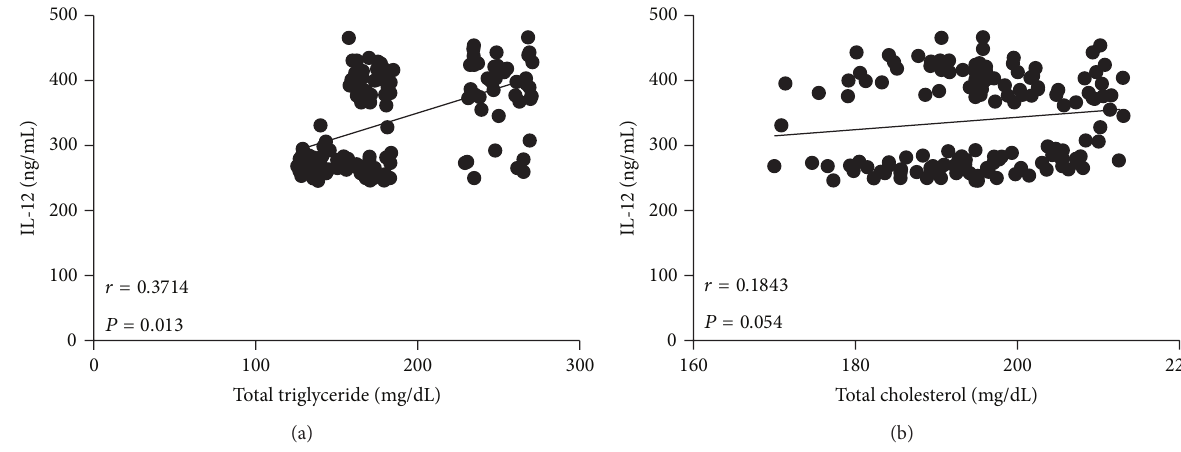
Figure 4: Relationship of the serum levels of IL-12 with total triglyceride and cholesterol levels. Serum IL-12 showed a positive significant association with high triglyceride levels (a), but not with total cholesterol (b). Coefficients ( r ) and P values were calculated by the Spearman’s correlation model. The correlation level was considered significant when 𝑃 < 0.05